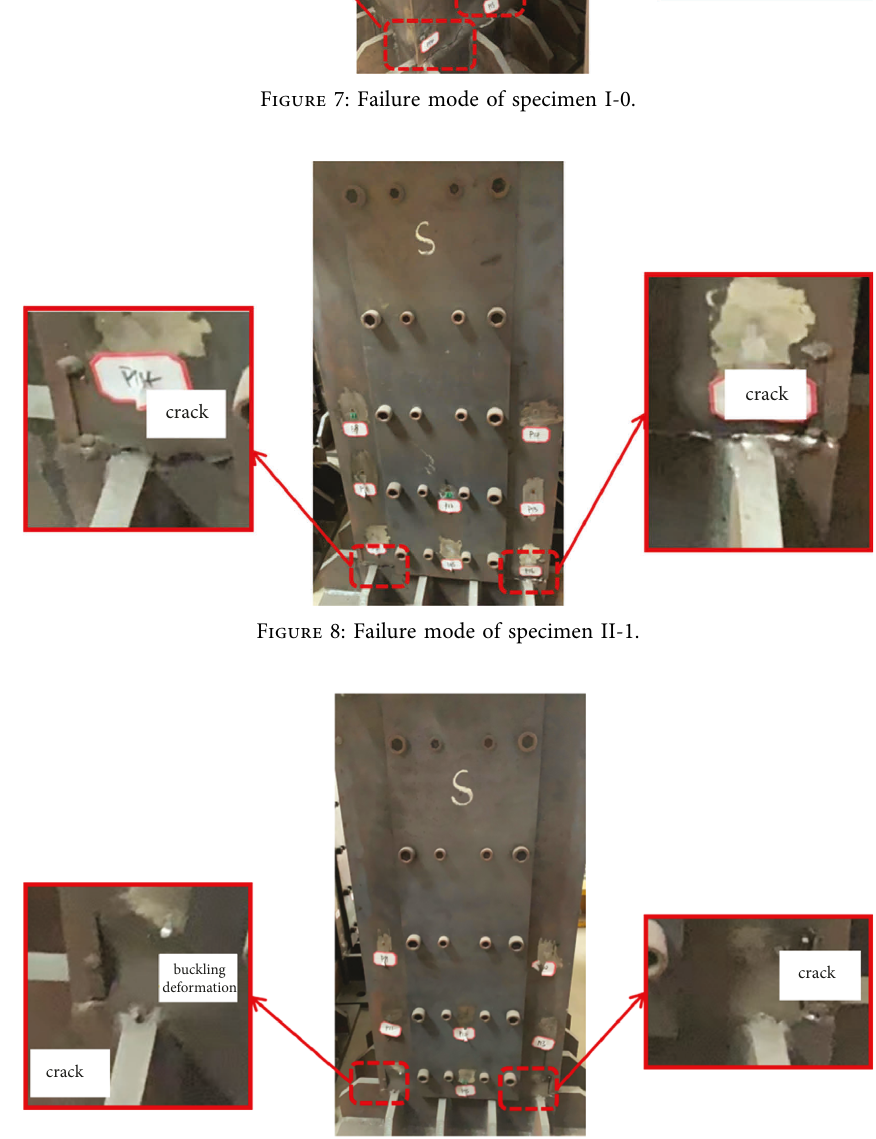
Figure 9: Failure mode of specimen II-2.